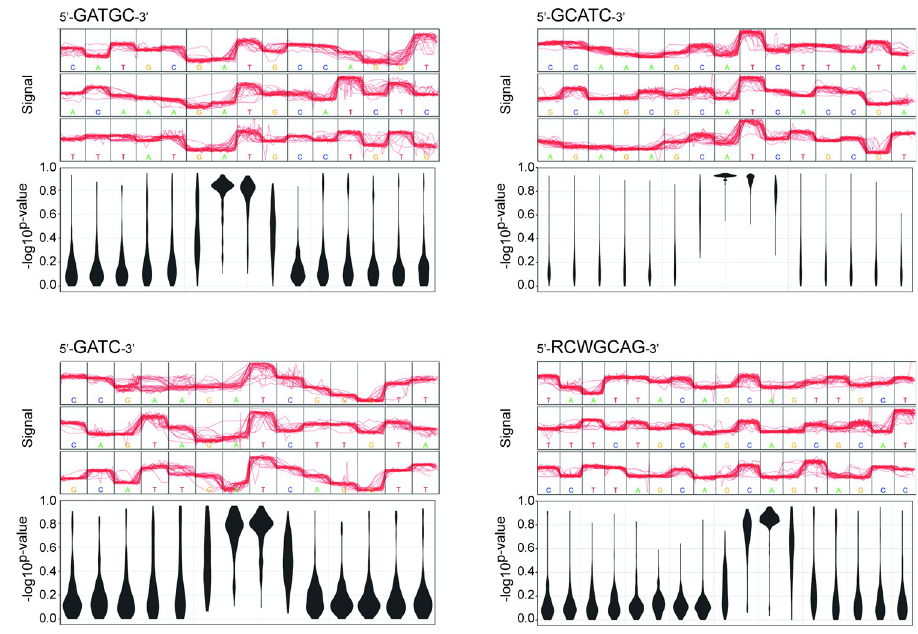
Fig 1. Prediction of the four most prominent DNA methylation patterns detected in the Nanopore sequencing dataset from strain BluCon085 using the methylation-calling tool Tombo version 1.5. For each identified methylation pattern, raw Nanopore signals (red lines) for three related sequence motifs in the genome and the corresponding violin plots are shown. The violin plots visualize the predicted methylation frequencies of single nucleotides (y-axis/-log10 p-value ) for related sequence motifs with a given proportion of methylated reads (x-axis/DNA sequence). Modified bases are highlighted in the violin plot by methylation frequencies greater than 0.8. The predicted methylated sites within the identified motifs are “A” and “T” in the related asymmetric sequences 5’-GATGC-3’ and 5’-GCATC-3’ , “A” and “T” in the palindromic sequence 5’-GATC-3’ , and “C” and “A” in the asymmetric sequence 5’-RCWGCAG-3’ . As for the latter one, the methylated reverse-complement counterpart could not be detected, and therefore hemi-methylation is